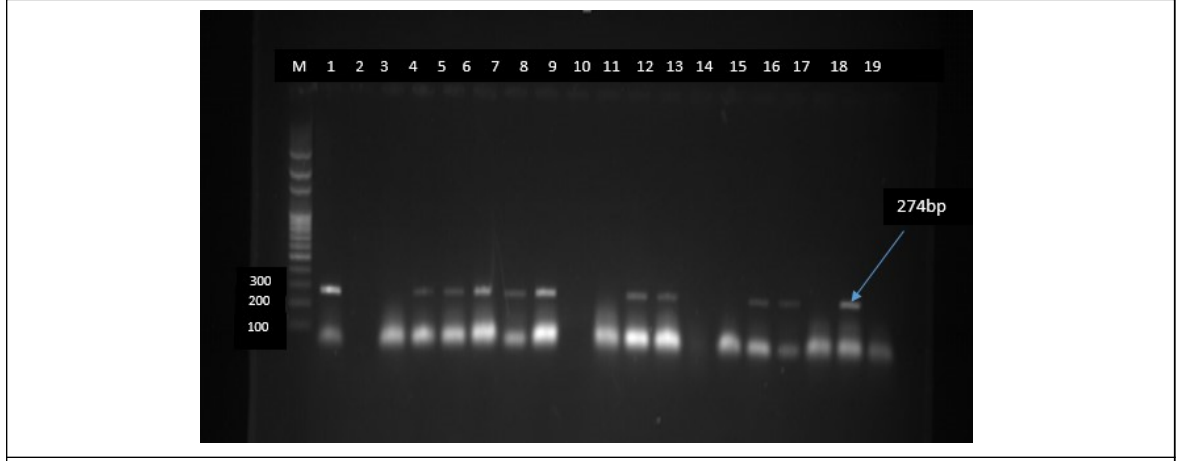
Note: M = Molecular marker, Lane 1 = Positive control, Lane 2 = Negative control, Lanes 4, 5, 6, 7, 8, 9, 11, 12, 16 and 18 = Positive samples. Figure 3: Electrophoresis of PCR products of members of Culex pipiens complex showing the presence of Cx. quinquefasciatus with a 274 DNA base pair Culex mosquito species occurrence differed with LGAs. Cx. q uinquefasciatus had the highest and least occurrence in Kosofe and Epe LGAs, respectively. All the other species had their highest densities in Epe LGA and least in Kosofe LGA except for Cx. decens which had its most occurrence in Eti-Osa LGA (Figure 4).